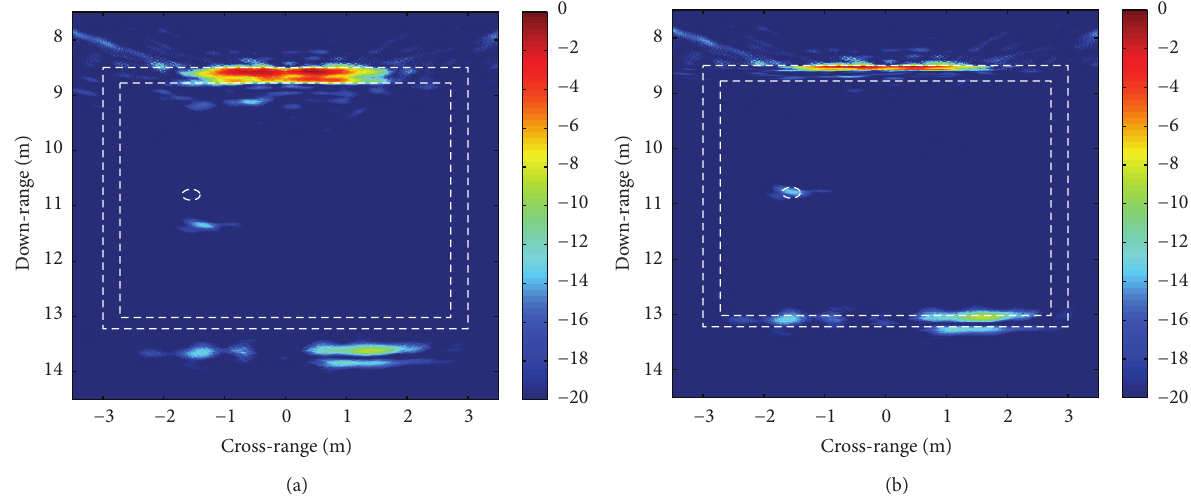
Figure 8: Comparison of imaging results of real data with 20dB dynamic range: (a) BP algorithm; (b) proposed method.